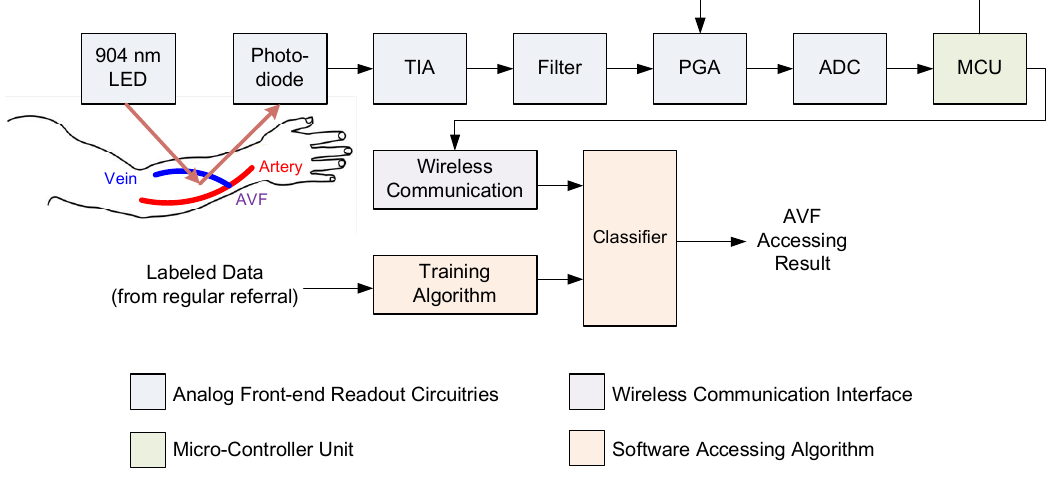
Figure 4. The system architecture of the proposed wireless PPG sensor system for accessing arteriovenous fistulas (AVFs), which is composed of a 904 nm wavelength light-emitting diode (LED), a photodiode (PD), a transimpedance amplifier (TIA), a band-pass filter, an analog–digital converter (ADC), a microcontroller unit (MCU), a wireless communication interface, and the proposed classifiers for accessing DOS and blood flow volume (BFV) of AVFs.